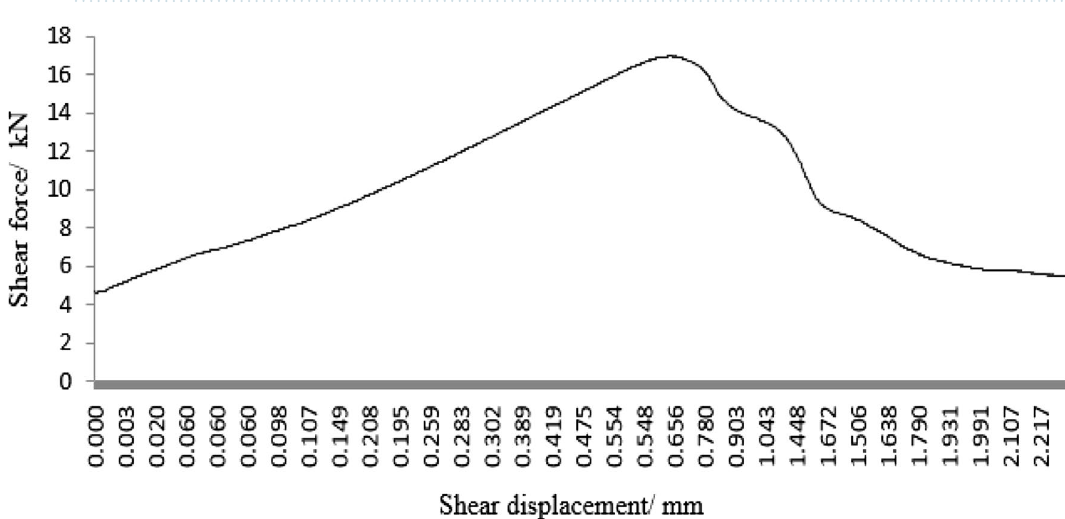
Figure 46. Shear force–shear displacement curve for a specimen containing 0–0.6 mm and 1–2.56 mm sand particles (two grain size